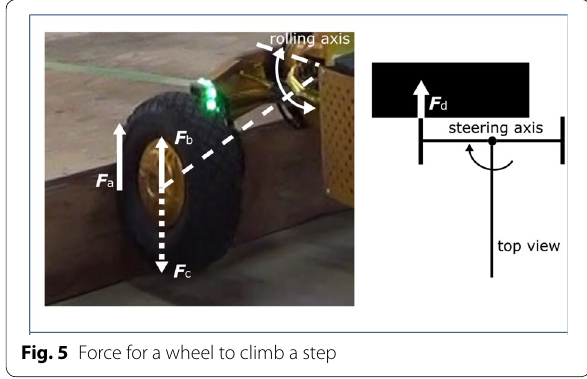
Fig. 5 Force for a wheel to climb a step